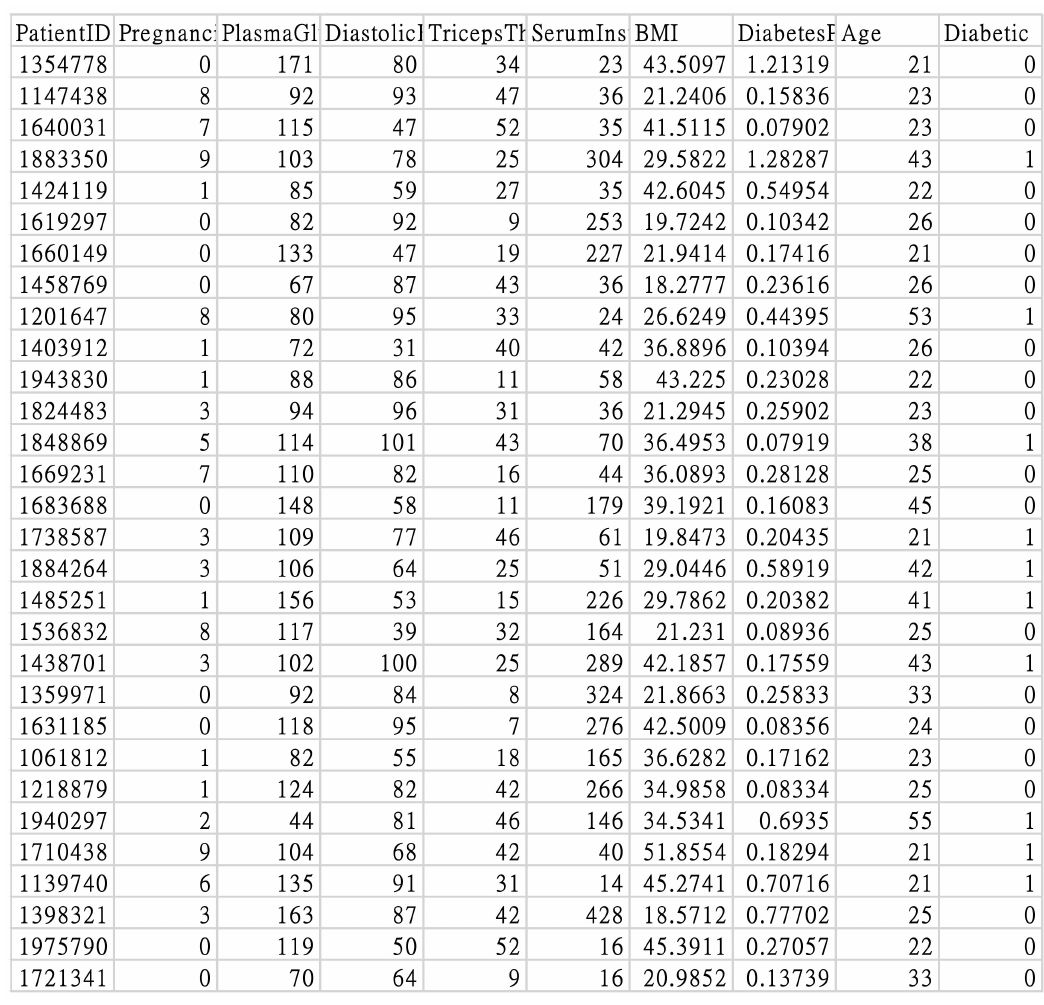
Figure 1. Original study data.